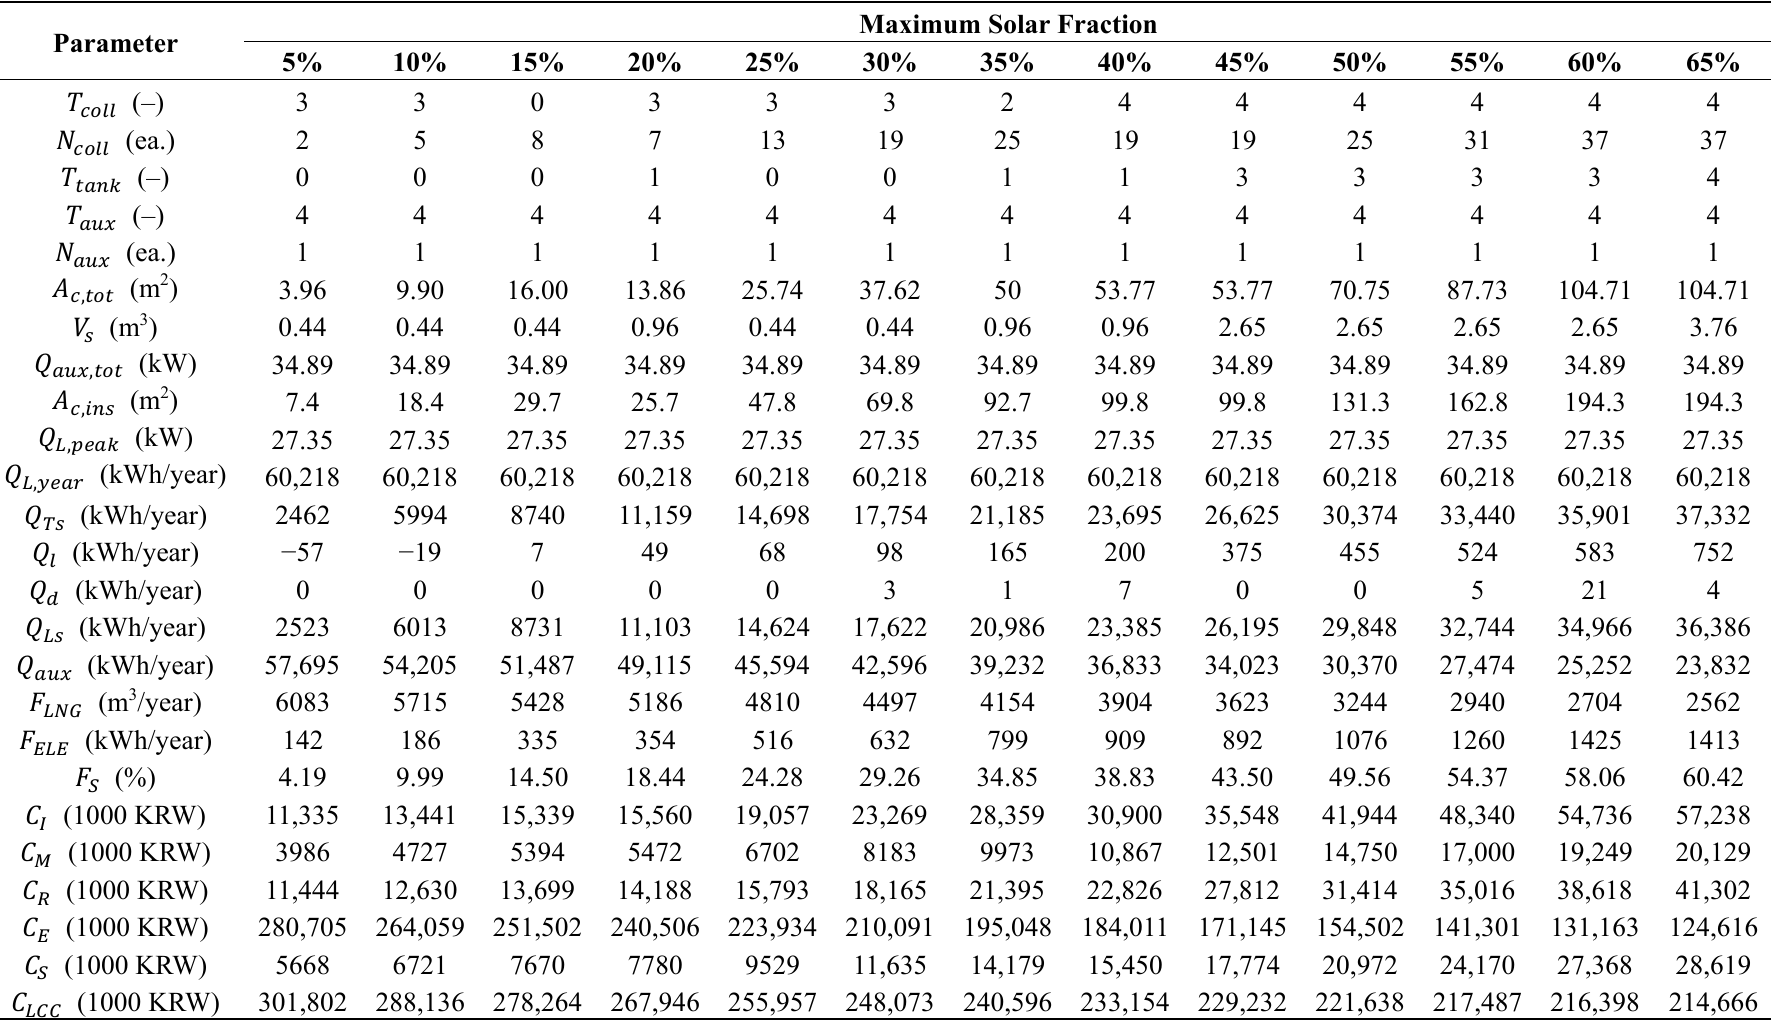
Table 7. Characteristics of the optimal SWH systems for the different maximum solar fractions.